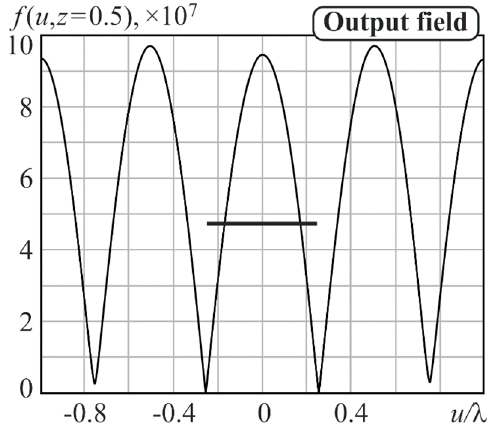
Figure 4. Field of Equation (4) at the distance z = 0.5 λ .